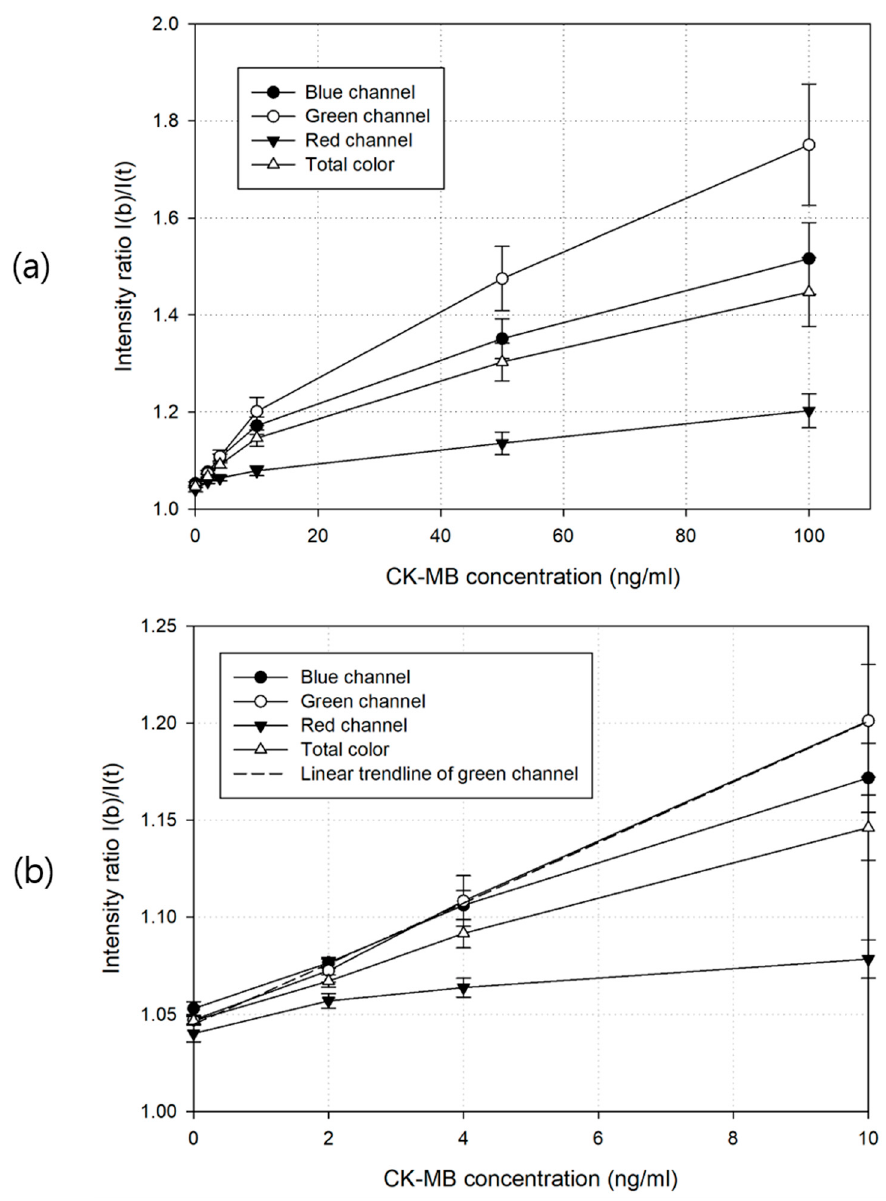
Figure 6. Pixel intensity response curves using the total color (i.e., original color), red, green, and blue images of the LFIA ( a ) and the enlarged response curves for the creatine kinase–muscle/brain (CK-MB) concentration range of 0 to 10 ng/mL ( b ). An average of 10 measurements is shown, and the error bars show the standard deviation. The dashed line in ( b ) shows the linear regression result of the green channel.